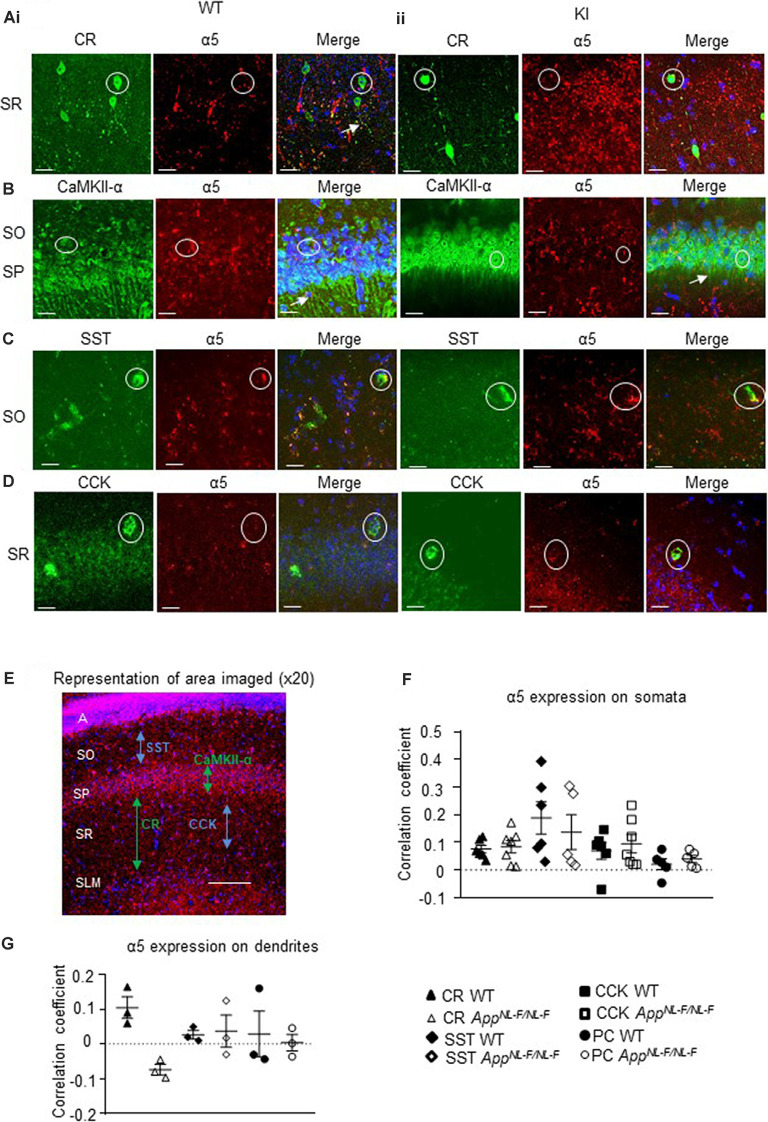
Expression of α5 subunit-containing GABAARs in CA1. (A–D) Confocal microscopy Z-stacks at 63× magnification showing α5 subunit-containing GABAAR expression (red, Alexa 488 or Alexa 568 label) on pyramidal neurons (CaMKII- α, green, FITC), CR interneurons (green, Alexa 488), SST interneurons (green, Texas Red), and CCK interneurons (green, Texas Red) in wild-type (i) and APPNL−F/NL−F animals (ii). Panels show individual channels and merged image with the nuclear stain DAPI (blue). Representative cell somata are outlined with white circles. White arrows indicate dendritic co-localization of α5. (E) Representative image labeled with α5 (red) and DAPI (blue) taken at 20× magnification in the CA1 of APPNL−F/NL−F to exemplify the region of data acquisition, arrows indicate the location of the sub-types of cells imaged and analyzed. Layers are labeled: alveus (A), stratum oriens (SO), stratum pyramidale (SP), stratum radiatum (SR), stratum lacunosum moleculare (SLM). (F) Analysis of α5 subunit-containing GABAAR expression on the soma of the four sub-types of neurons investigated. Each data point represents an average value (from five cells) analyzed form individual animals at 12–18 months of age (n = 5–7 mice studies per cohort). (G) Analysis of α5 subunit-containing GABAAR expression on the dendrites of CR cells, SST cells, and pyramidal neurons (n = 3 mice per genotype with visible proximal dendrites analyzed for five cells per animal). (F,G) Results are expressed as a scatter plot ± (SEM; results not significant, P > 0.05), of Pearson correlation coefficient as a measure of co-localization, after application of Fisher’s transformation. Data analyzed with a one-way ANOVA and post hoc Tukey test.